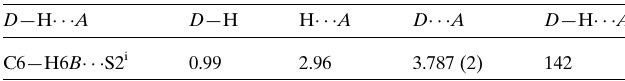
Table 1 Hydrogen-bond geometry (A˚ , (cid:3) ).